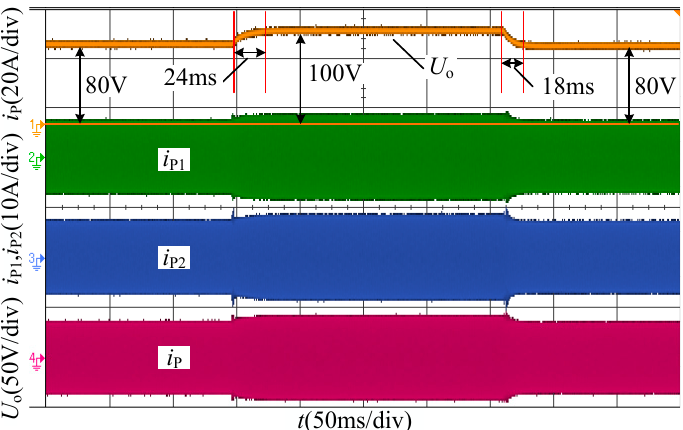
Figure 13. Close loop system response to step change in reference output load voltage from 80 to 100 V and then back to 80 V.